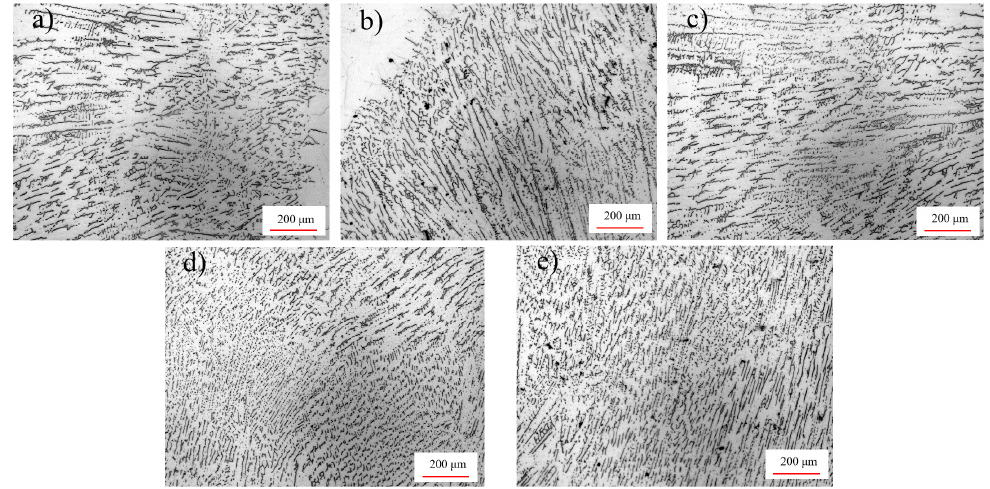
Figure 8. Weld grain morphology: ( a – e ) U 0 –U 4 , respectively. By comparing U 3 and U 4 , it can be seen that, under the mid-welding regulation, the columnar crystal zone of the weld was the least obvious, and the proportion of the equi- axed dendrite crystals was the largest. This is because the application of high-energy ul- trasound in the welding process brought the acoustic flow effect [35] and ultrasonic cavi- tation effect [36,37], which accelerated the molten pool flowing and thermal convective circulation; therefore, the columnar crystals were broken and taken away from the fusion line zone by the melting. The above phenomena provide the possibility for the nucleation of equiaxed fine crystals [38]. The microstructures of PMZs (partially molten zones) of different comparison groups are shown in Figure 9. In the PMZ zone of group U 0 , the matrix was composed of austen- ites, and many large chain-shaped δ ferrites were found at the grain boundary. In groups U 1 and U 2 , under the offline regulation, the large chain-shaped δ ferrites were reduced due to the introduction of high-energy ultrasound. In groups U 3 and U 4 , under the online regulation, the large ferrites were uniformly refined and dispersed to the austenite grain boundary for precipitation, and the grains were clearly refined. Figure 9. Morphology of the partially melted zone (PMZ) of the weld: ( a – e ) U 0 –U 4 , respectively. Through comparative experiments, it was found that the online regulation of high- energy ultrasound can play a role in refining the crystals in the melting zone. Due to the